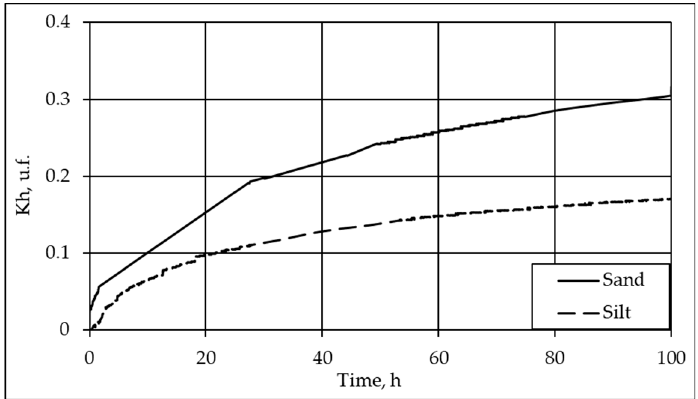
Figure 10. Time-dependent pore methane hydrate formation in sand 2 ( Si = 56%) and silt 2 ( Si = 57%) at (cid:442) 3 °C.